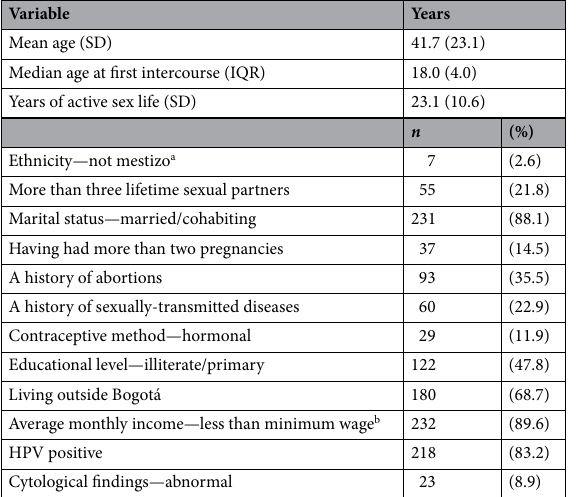
Table 1. Base line demographic characteristics and risk factors for the 262 women included in the study. a This category included Indigenous and Afro Colombian ethnicities. b The Colombian minimum average monthly income would be roughly US$